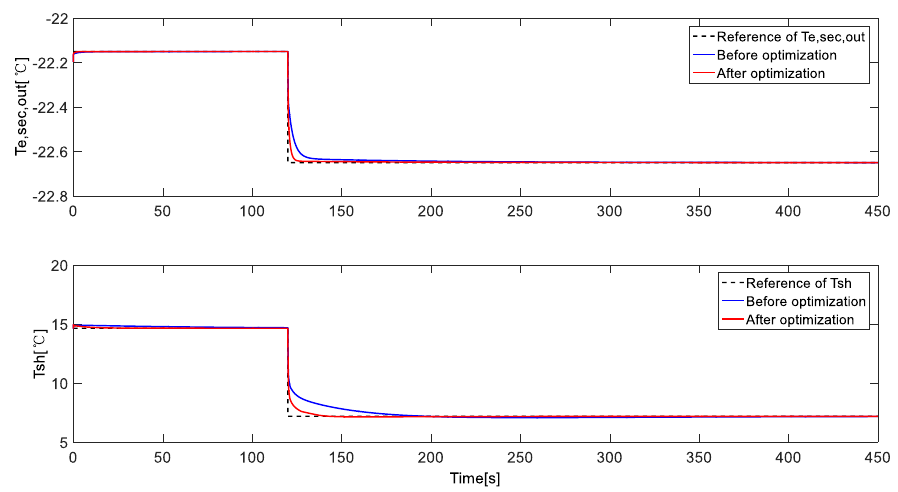
Figure 8. The comparison of the control performance of the controller before & after optimization.